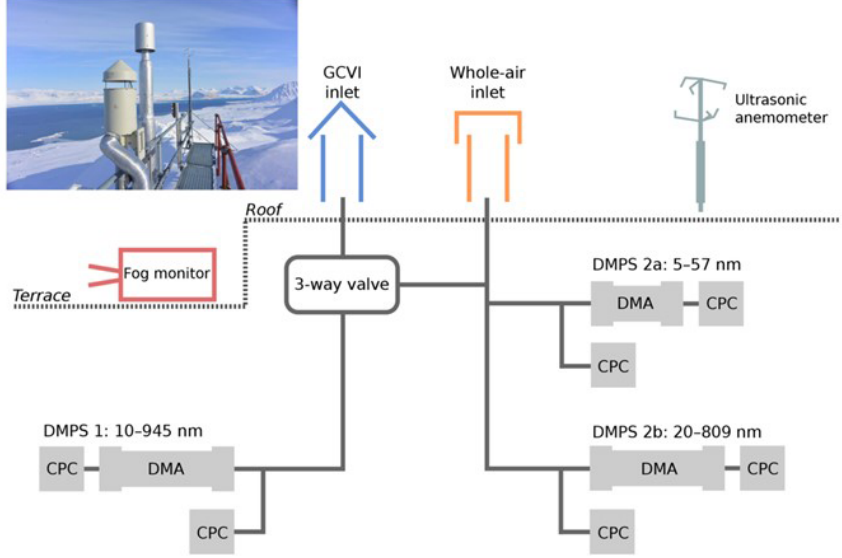
Figure 6. Schematic illustration of the experimental set-up at the Zeppelin Observatory. The diagram shows how the whole-air inlet (orange) and the ground-based counterflow virtual impactor (GCVI) inlet (blue) are connected to the differential mobility analysers (DMAs) and condensation particle counters (CPCs). The three-way valve switches the sample flow to the instruments on the left-hand side from the GCVI inlet to the whole-air inlet when there is no cloud to be sampled. Cloud sampling is activated if the visibility drops below 1km (measured by a visibility sensor (not pictured) next to the GCVI inlet). Auxiliary measurements from a fog monitor and an ultrasonic anemometer are included in the data analysis. Figure from Karlsson et al.